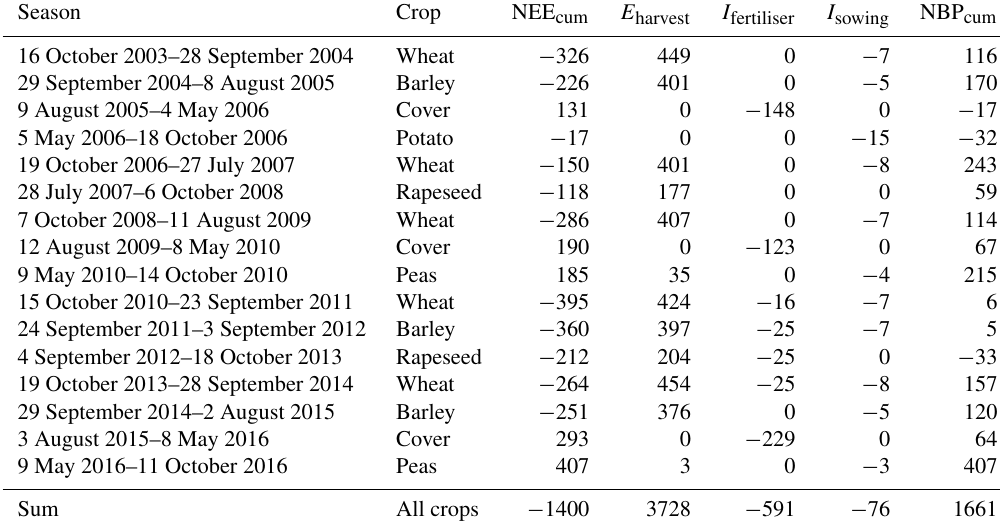
Table B1. Seasonal carbon budget expressed as cumulative net biome production (NBP cum ) and its contributing terms of the 16 full crop seasons between 2004 and 2016 (units:gCm − 2 ). A season is defined as the period from the sowing of the current crop until the sowing of the following crop. NEE cum is the cumulative net ecosystem exchange, E harvest is the C export through harvest, and I fertiliser and E sowing are the C imports through organic fertilisation and sowing, respectively. The sums over all crop seasons are also given.